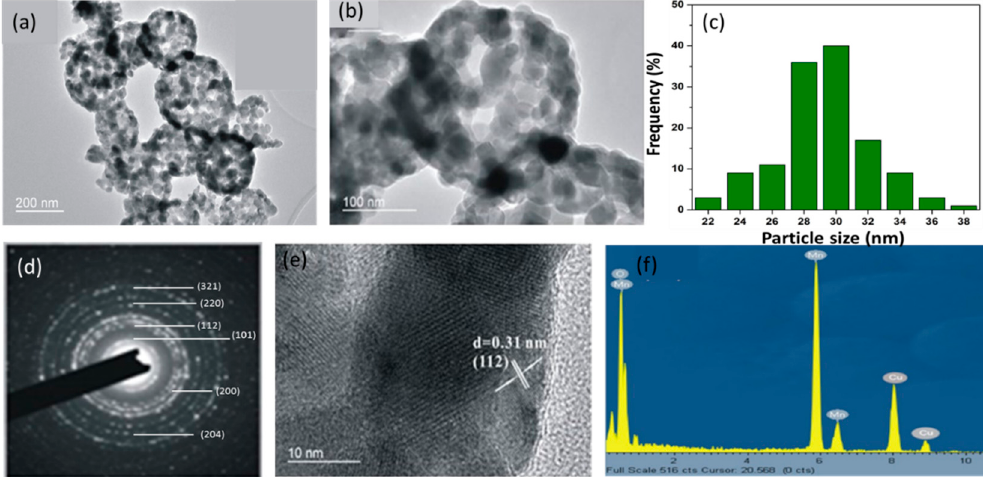
Figure 3. ( a , b ) the TEM images of the MOHNs; ( c ) the particle size distribution of Mn 3 O 4 nanoparticles on the hollow nanocages of MOHNs; ( d ) the SAED pattern of the MOHNs; ( e ) the HRTEM image of the lattice fringe of the MOHNs; and ( f ) the EDS spectrum of